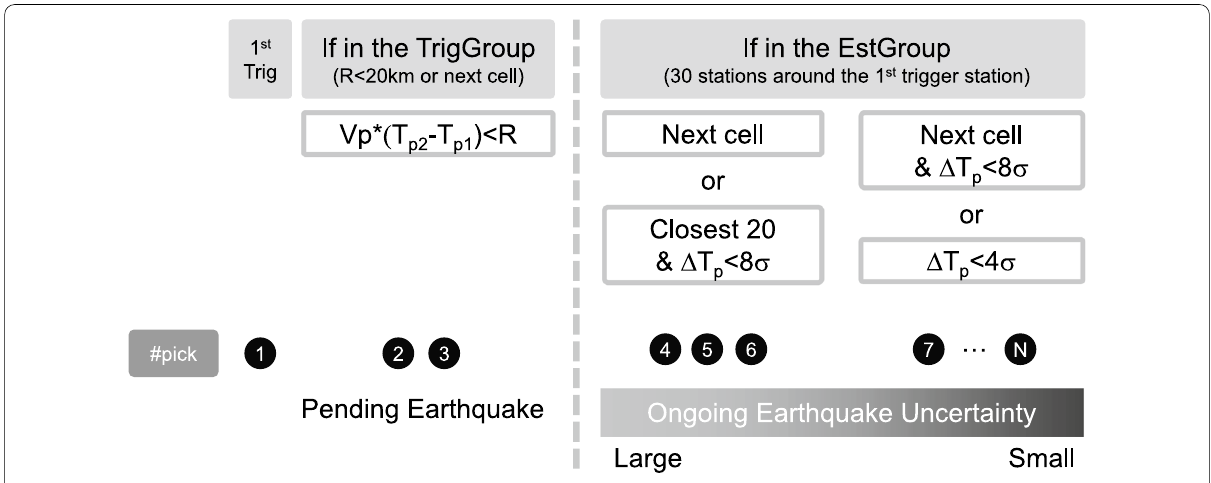
Fig. 2 Phase association algorithm designed for the Taiwan network